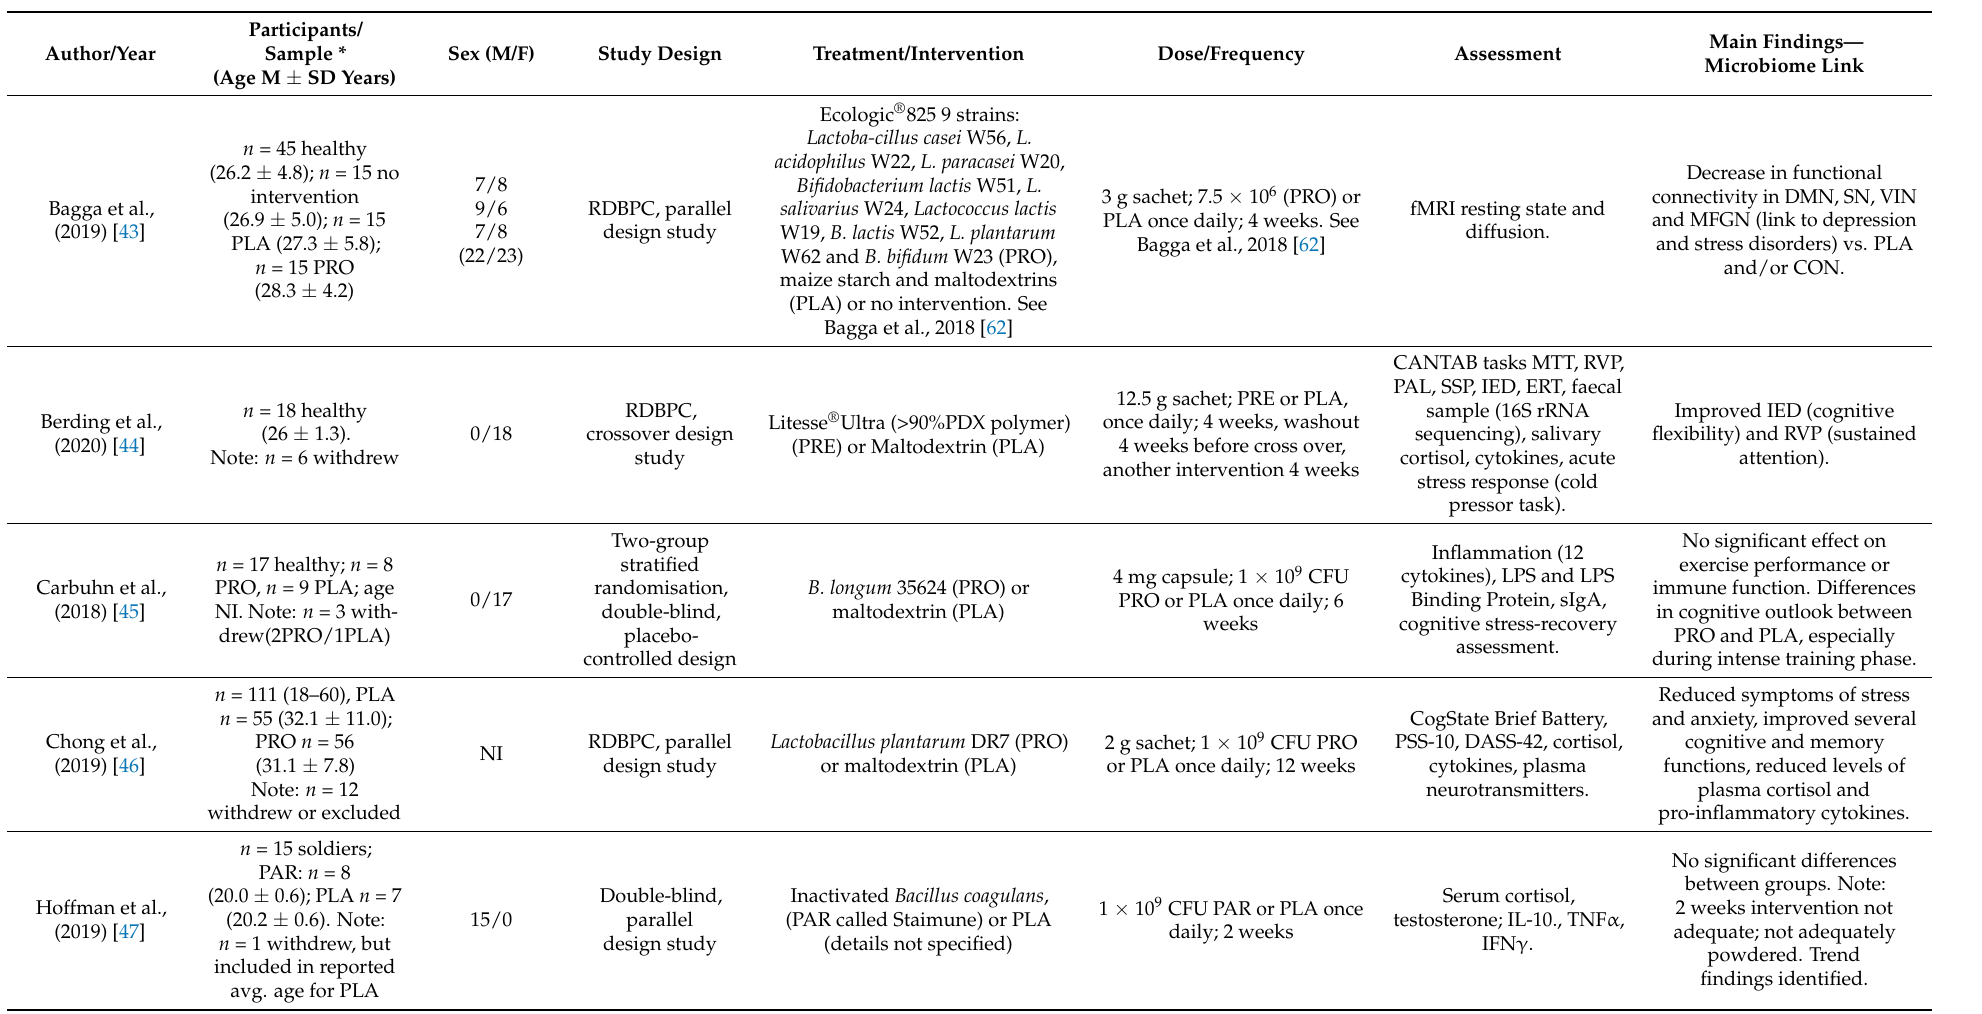
Table 3. Human studies listed in alphabetical order describing interventions on the gut microbiota and the effects on cognition, brain structures and function, and